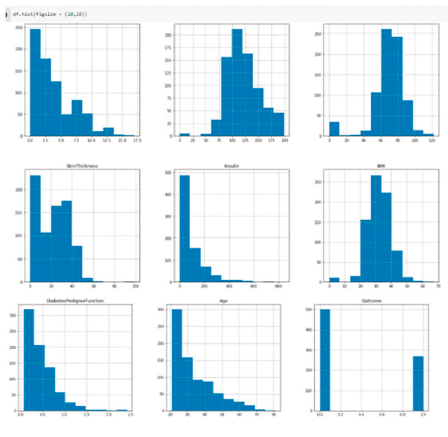
Figure 6: Histogram.